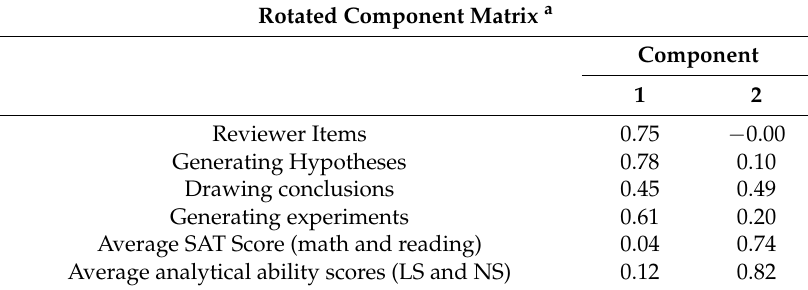
Table 18. Rotated principal component matrix in the Study 2 analysis of the total scores of all our subscales with the exception of the editor items, and the analytical ability tests and